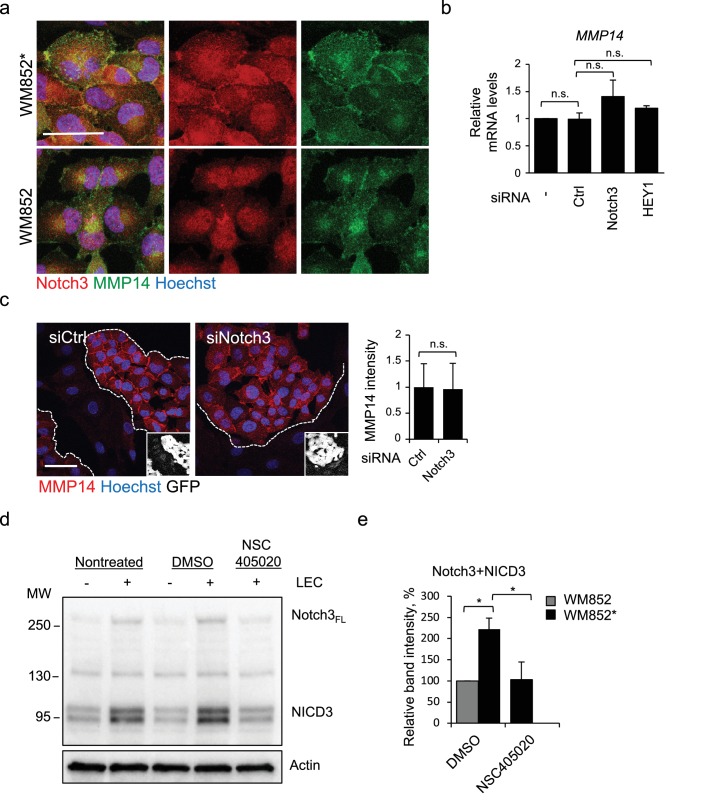
Notch3 does not regulate MMP14 expression, but MMP14 positively regulates Notch3.(a) Representative enlargement with separated channels of the images in Figure 4c. Merge, Notch3 (red) and MMP14 (green) stainings are shown. (b) MMP14 mRNA fold change in WM852* treated with the indicated siRNAs for 72 hr. Data averaged from two independent experiments is shown. n.s., non-significant. (c) Right panels: representative confocal images of MMP14 (red) in WM852* after the cells were treated with indicated siRNAs for 72 hr. Nuclei were counterstained with Hoechst 33342. The dashed lines indicate LEC-melanoma (GFP expressing cells (white in the inset) border. Scale bar = 50 µm. Left panel: quantification of the MMP14 intensity analysed in four images per condition from two independent experiments. More than 100 cells were always analysed per condition. Average is shown, error bars represent SD. n.s., non-significant (d) Immunoblot using anti-Notch3 (upper panels) and anti-actin (lower panels) antibodies of WM852 and WM852* (+LEC) treated as indicated and subjected to magnetic separation prior to sample preparation. Notch3FL: full length Notch3; NICD3: Notch3 intracellular domain. Panels represent the bands from the same membrane and same exposure time. (e) Relative Notch3 and cleaved NICD3 band intensity normalized to actin of two independent experiments performed as in (d). Average is shown, error bars represent SD; *: p<0.05. Full size confocal images are available as source data 2.